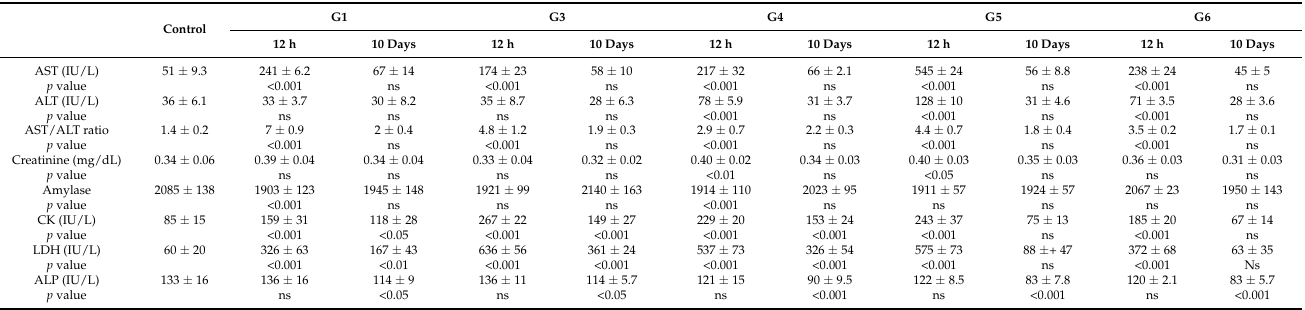
Table 3. Serum levels of the enzymes analyzed: aspartate transaminase (AST), alanine transaminase (ALT), creatinine, amylase, creatine kinase (CK), lactate dehydrogenase (LDH), and alkaline phos- phatase (ALP). The units of measurement for each parameter analyzed are indicated in parentheses: international units/liter (IU/L) or milligrams/deciliter (mg/dL). The p value indicates either the statistical significance of each experimental group compared to the control, or the non-existence of statistically significant differences (ns).